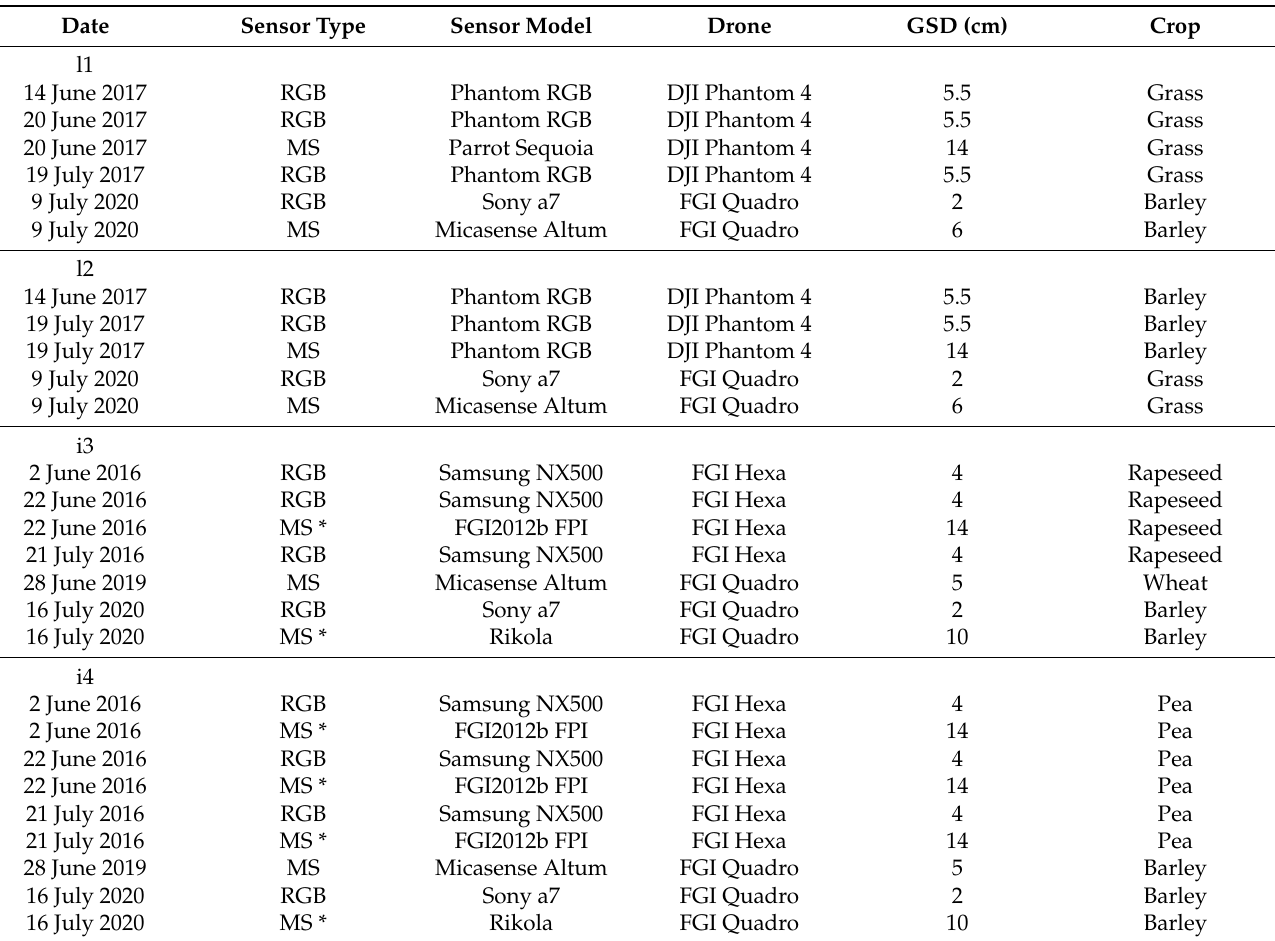
Table 2. Overview of drone data: data collection date (Date), camera type: RGB or multispectral (MS) (* the camera collected 36 bands but only four of them were used in this study), sensor model, drone, original ground sample distance at the ground level (GSD), and crop type in the field during data